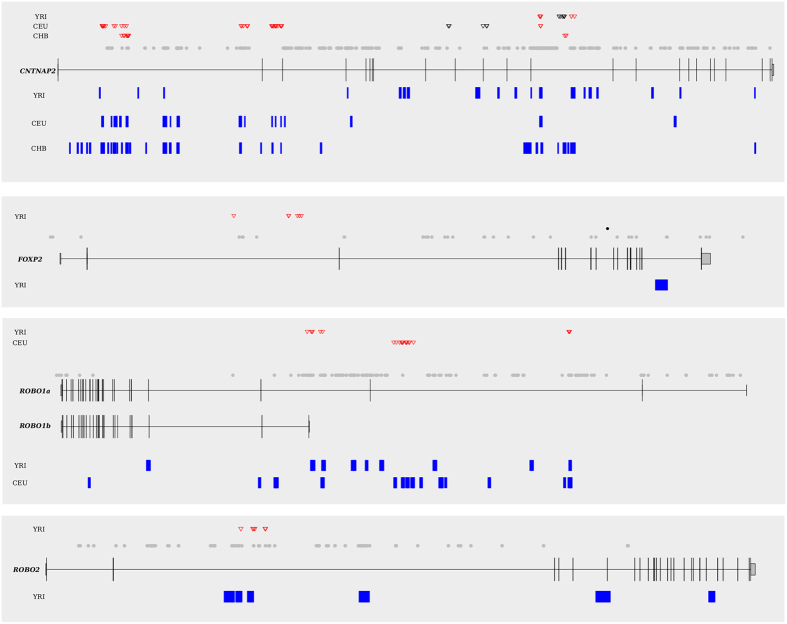
Location of the selection targets in human populations.The gene structures of CNTNAP2 (A), FOXP2 (B), ROBO1 (C), and ROBO2 (D) are shown. Candidate selection targets are shown as triangles, with colors indicating the derived allele frequency of each SNP (red: DAF > 0.80, black: DAF < 0.80). Blue rectangles represent genomic windows with a DH value lower than the 1th percentile (see methods for details). The location of variants cataloged as modern-human-specific sites by56 is shown (gray circles). The black dot in (B) represents rs114972925 (see text).